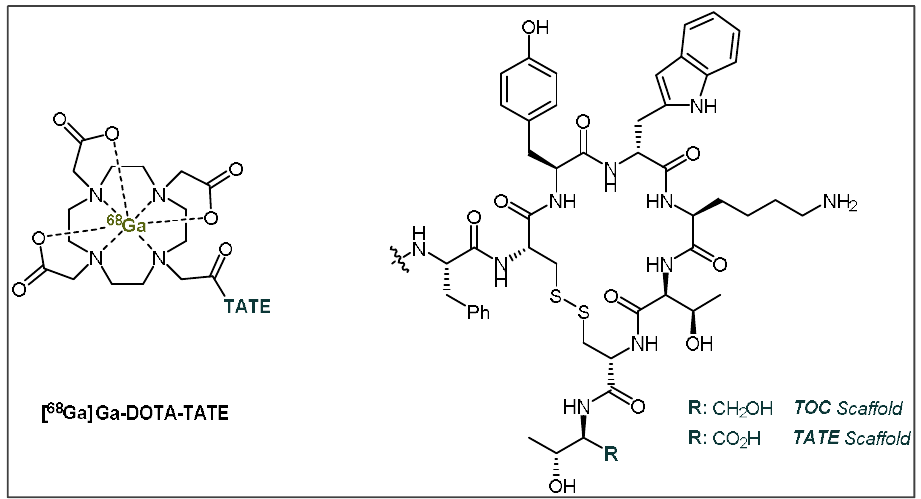
Figure 5. General structures of [ 68 Ga]Ga-DOTA-TATE (Netspot ® ) and [ 68 Ga]Ga-DOTA-TOC. TATE = Tyr 3 -octreotate; TOC = Tyr 3 -octreotide. 18 F is a cyclotron-produced radionuclide with a longer t 1/2 than 68 Ga, which allows for